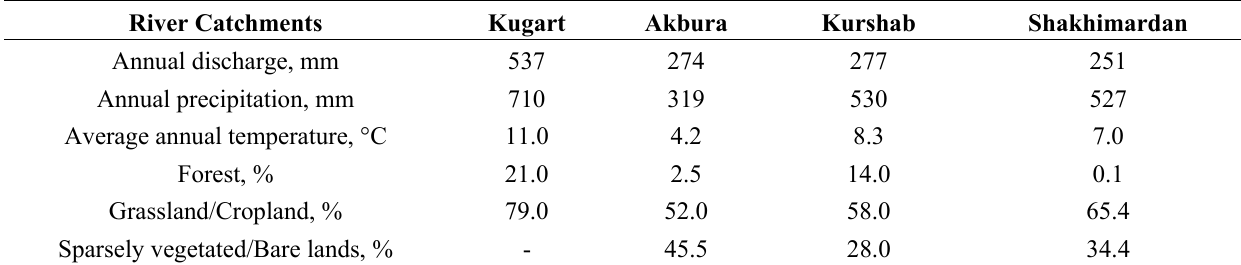
Table 2. Hydrometeorological and land-use characteristics of the four studied catchments.